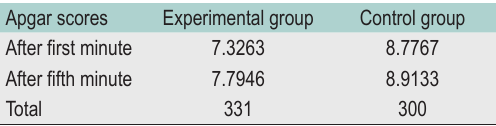
TABLE 2. Apgar scores at the fi rst and fi fth minutes of the TABLE 4. Representation of RDS by gestational weeks in the experimental group